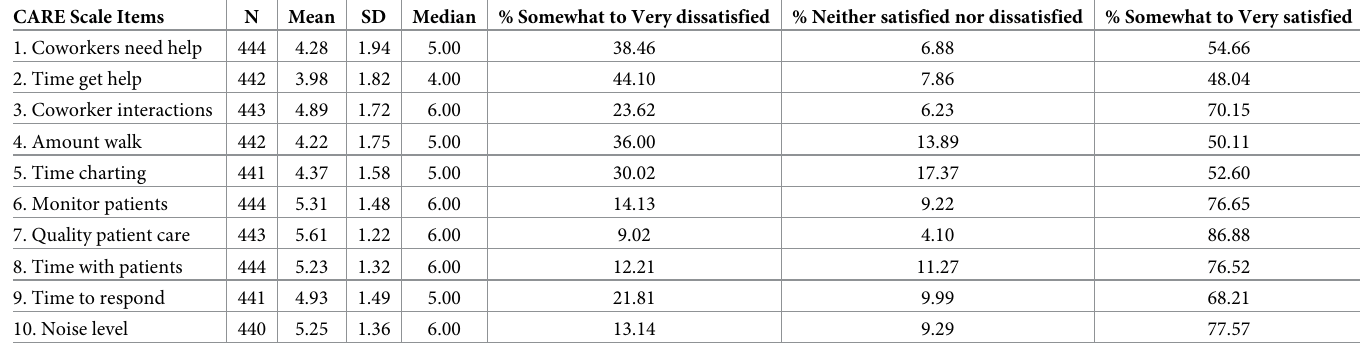
ered for item deletion. Overall and individual Kaiser’s Measure of Sampling Adequacy values between 0.80 and 0.97 indicated that the data were appropriate for factor analysis. With only one eigenvalue greater than one and explaining 88% of the variance, the analysis indicated that a one-factor model might be most appropriate. However, an investigation of the partial residuals and root mean square residuals suggested that more factors may need to be extracted. Two- and three- factor models reduced these values, and thus, were also considered for rotation and theoretical interpretation. The one-factor model reflected the unidimensional aspect of the correlations between all items with loadings ranging from 0.44 to 0.83 and accounting for 87% of the total common variance between the items. The two-factor model reflected the items that relate more to nursing tasks and efficiency, such as integration between coworkers and time spent in different activities, highly loaded on the first factor and items more related to patient care and experience on the second factor (Table 6). The variance explained by each factor was close to even, with the first factor accounting for 56.2% and the second factor accounting for 46.6% of the common variance. The biggest difference in the three-factor compared to the two-factor model was that it separated the first factor from the two-factor model into two different factors for nurse integration and task efficiency (Table 7). The third factor still represented patient care items. The amount of variance explained by each factor was relatively similar, with 42.8% explained by the first factor, 37.4% by the second, and 32.3% by the third. Site responses were Table 4. Phase 1 CARE items response